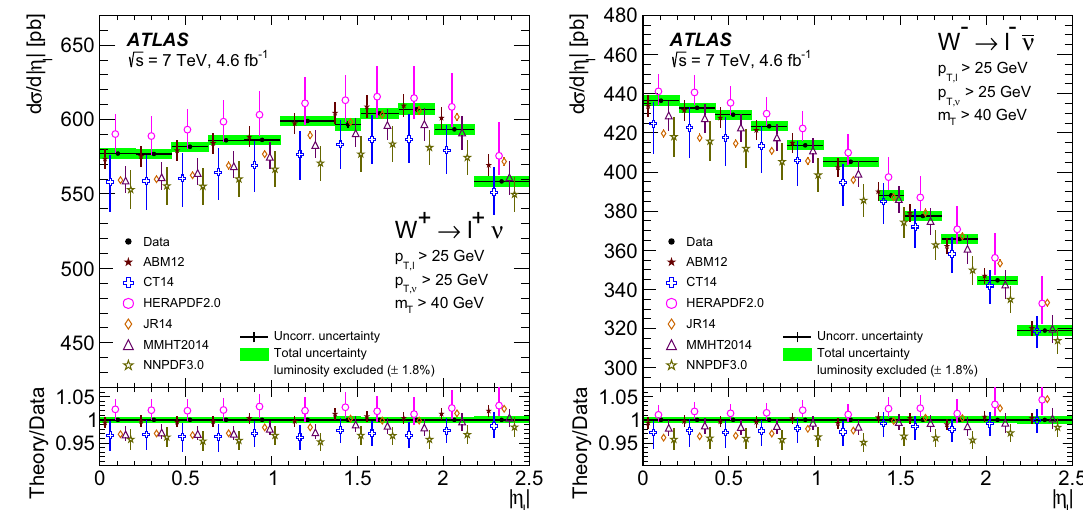
Fig. 21 Differential d σ W + / d | η (cid:3) | ( left ) and d σ W − / d | η (cid:3) | ( right ) cross- section measurement for W → (cid:3)ν . Predictions computed at NNLO QCD with NLO EW corrections using various PDF sets ( open symbols ) are compared to the data ( full points ). The ratio of theoretical predic-